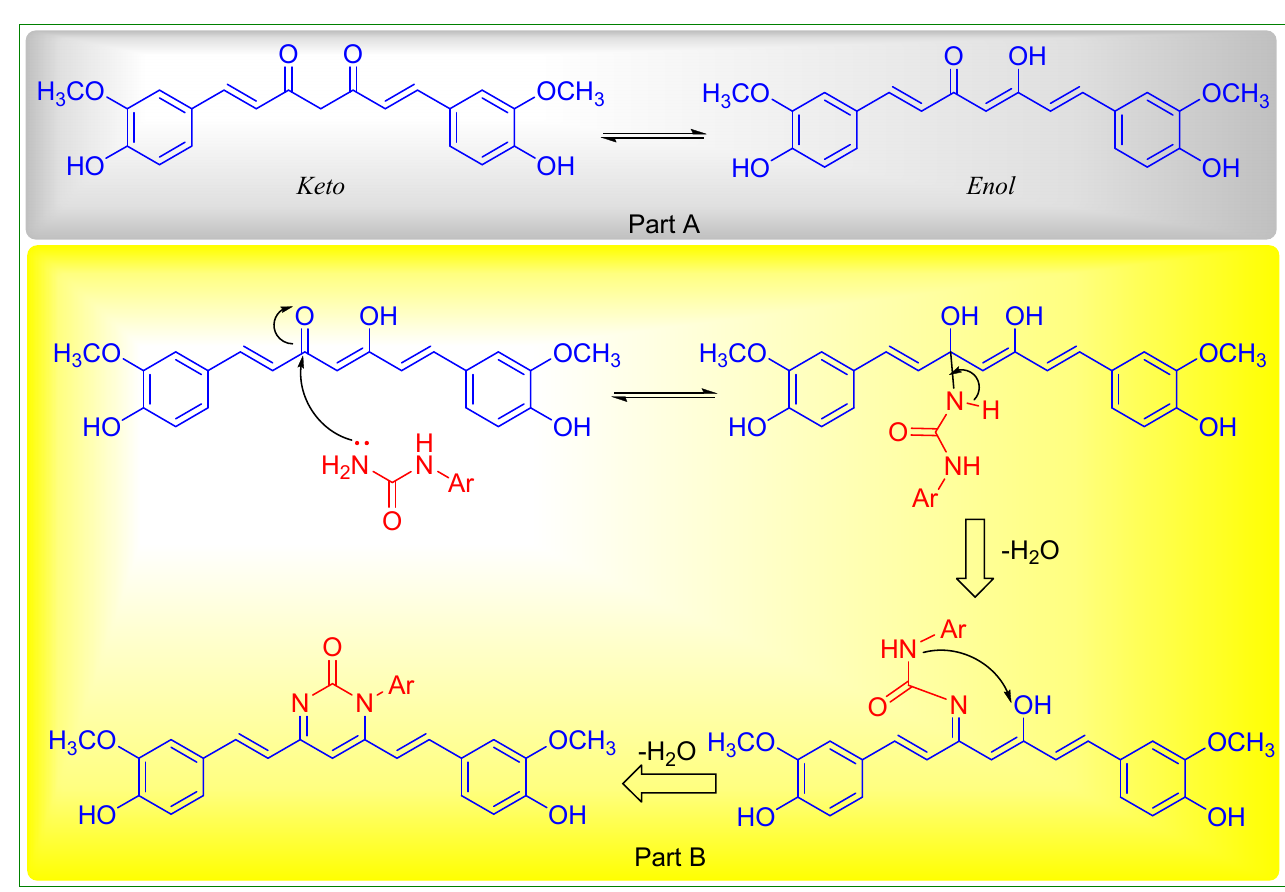
Scheme 1. Protocol for the synthesis of semi-synthetic curcumin analogues ( C1-C3 ).